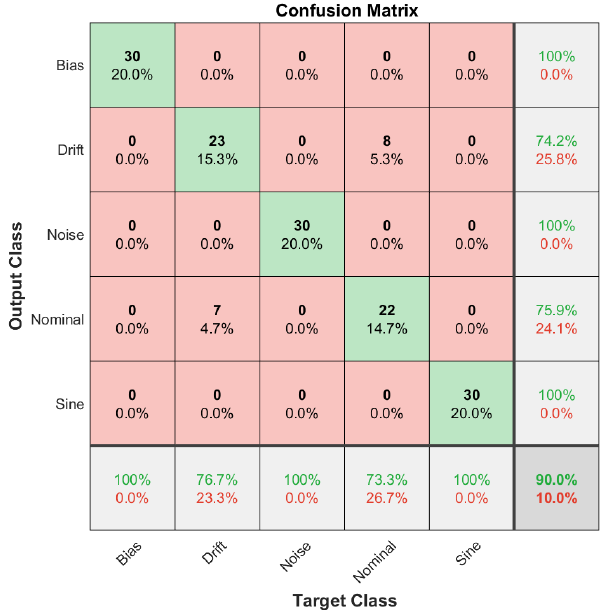
Figure 13. Confusion matrix for the validation data set showing that a considerable amount of the misclassified samples are between drift fault and nominal